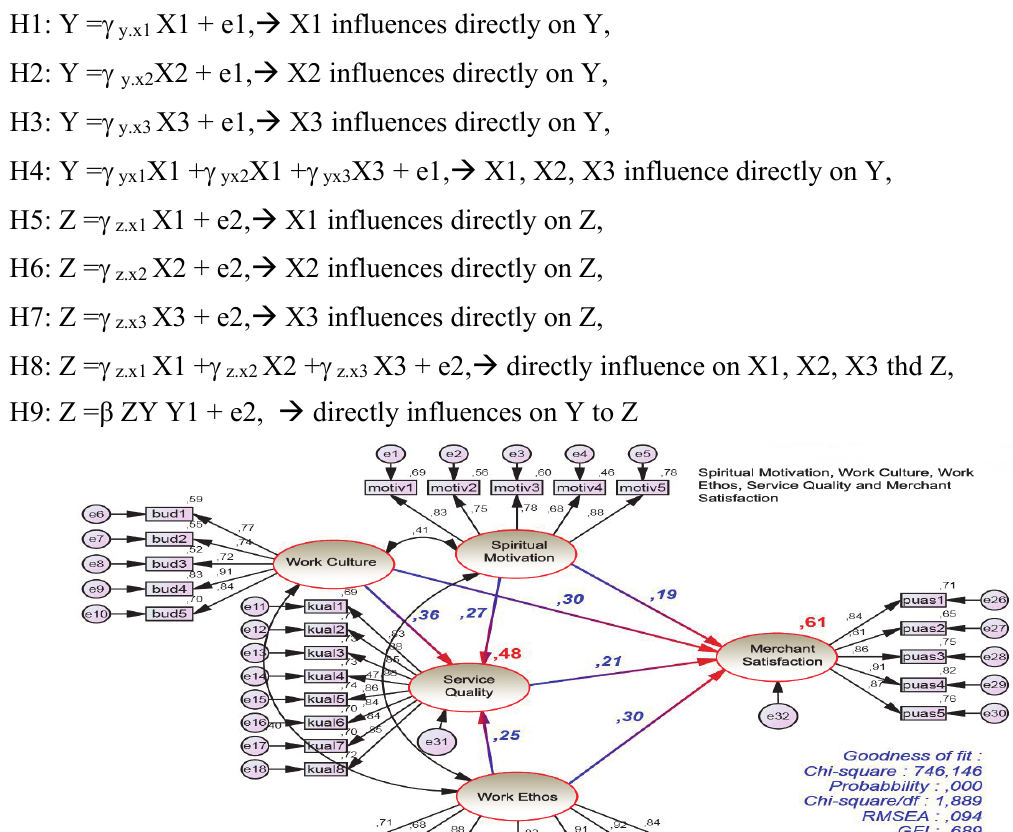
Standardized Direct Effects